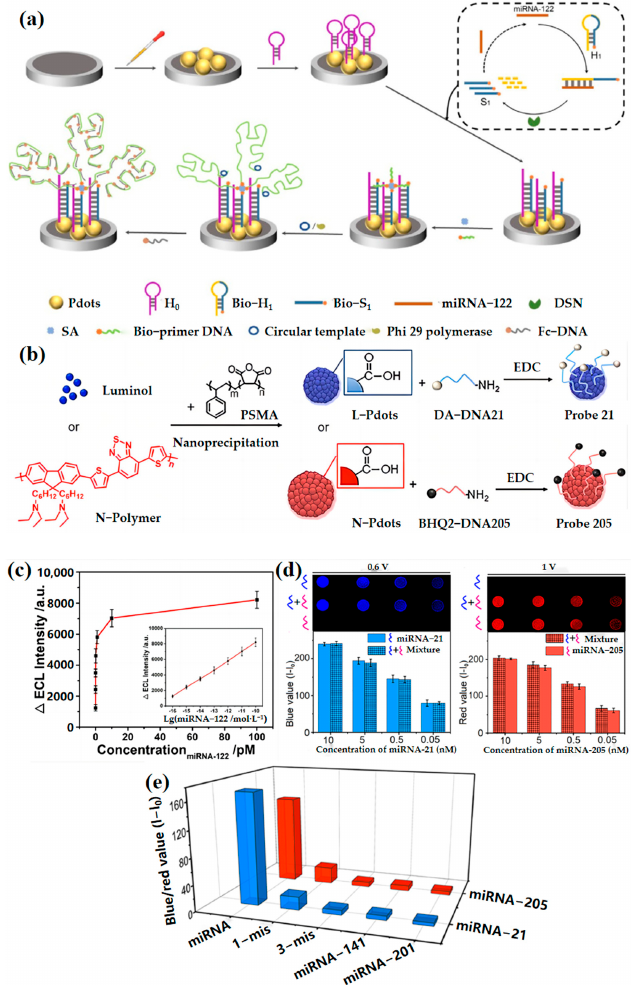
Figure 5. ( a ) Diagram and principle for miRNA-122 detection by the ECL sensor. Adapted with permission from [72]. ( b ) Schematic Diagrams of preparation of Probe 21 and Probe 205. Adapted with permission from [73]. ( c ) The relationship between the ∆ ECL intensities and the concentrations of miRNA-122 from 0.1 fM to 100 pM. Inset: the linear relationship. Adapted with permission from [72]. ( d ) Blue and red channels for detection of 10, 5, 0.5, and 0.05 nM miRNA-21, miRNA205, and their mixture of equivalent concentration, respectively. Adapted with permission from [73]. ( e ) Specificity of the proposed imaging method for detection of miRNA-21, miRNA-205, their single-base-mismatched and three-base-mismatched miRNA, miRNA-141, and miRNA-203 at 1 nM. Adapted with permission from [73].